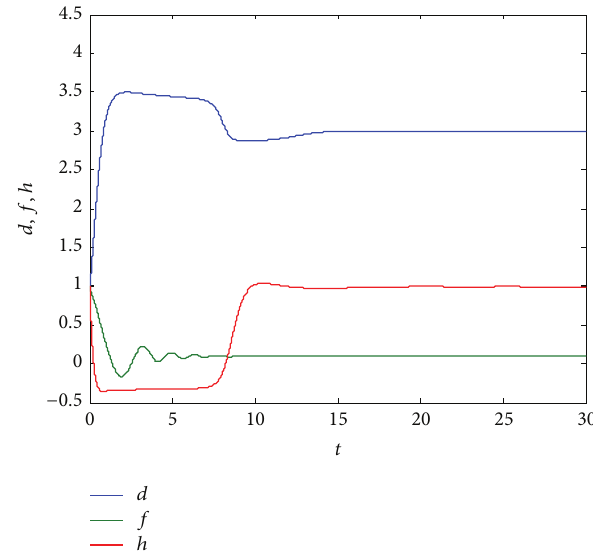
Figure 1: Time evolution of parameter estimations for system (25).